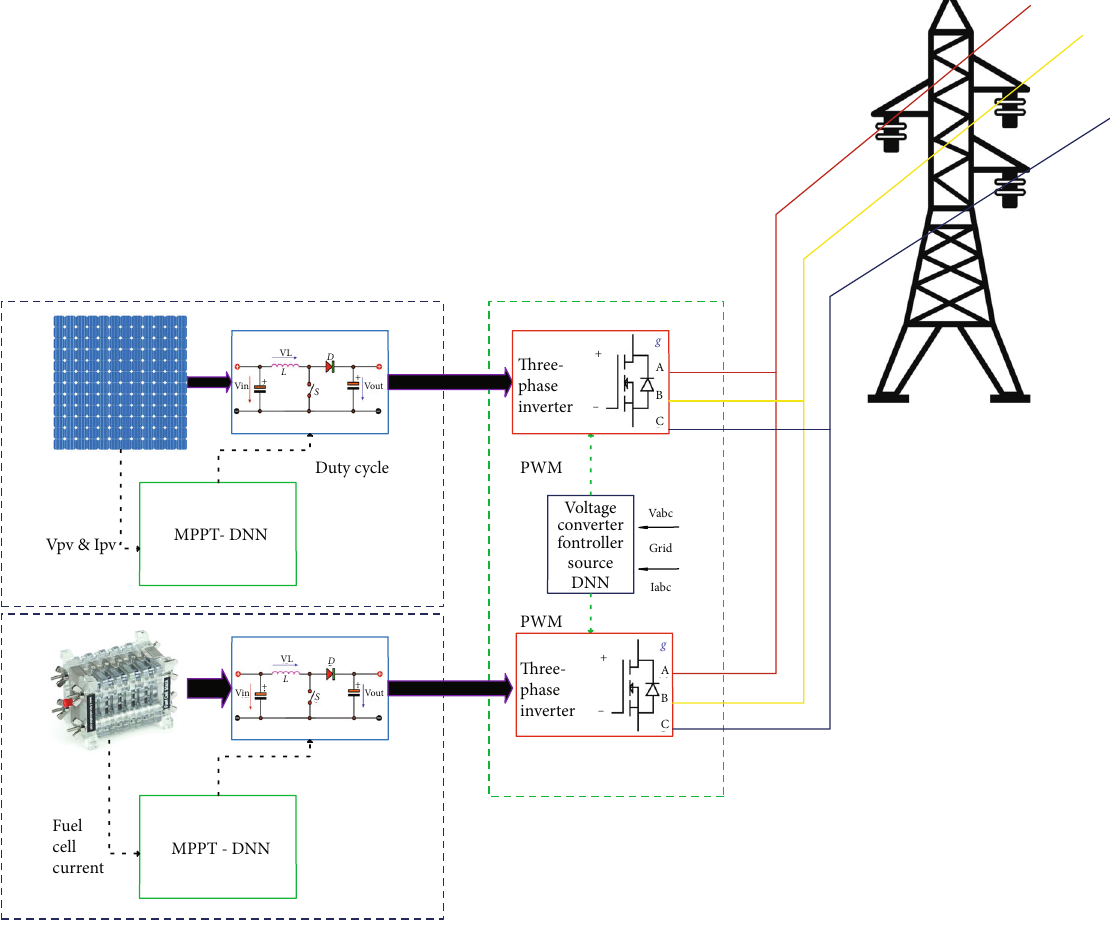
Figure 1: Block diagram of the proposed microgrid system and its controller.